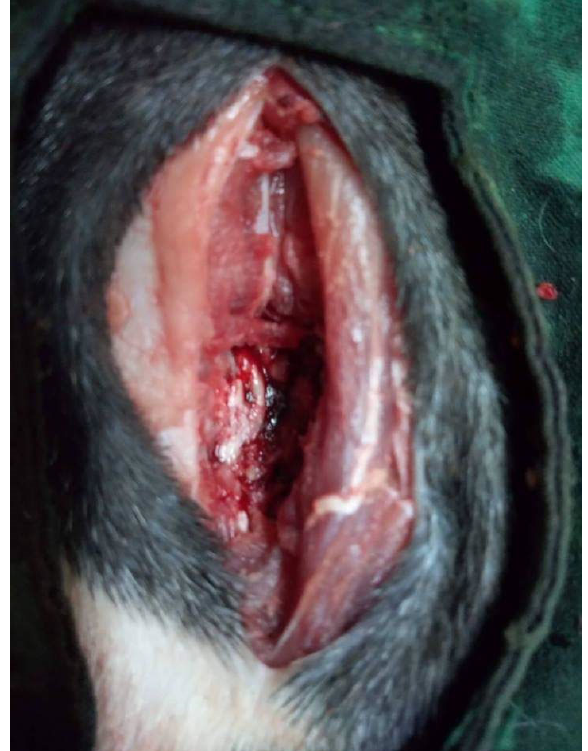
Figure 4. Dorsal laminectomy L6, L7, and S1 (case 1)